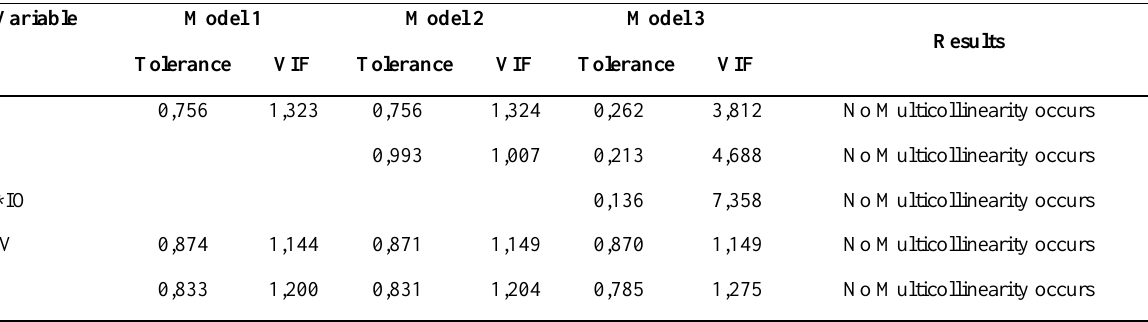
Table 2: Multicollinearity Test